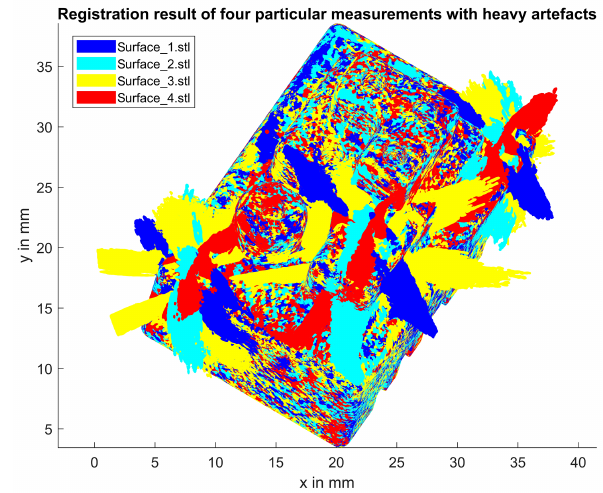
Figure 3. Registration result of four different measurements using LQV